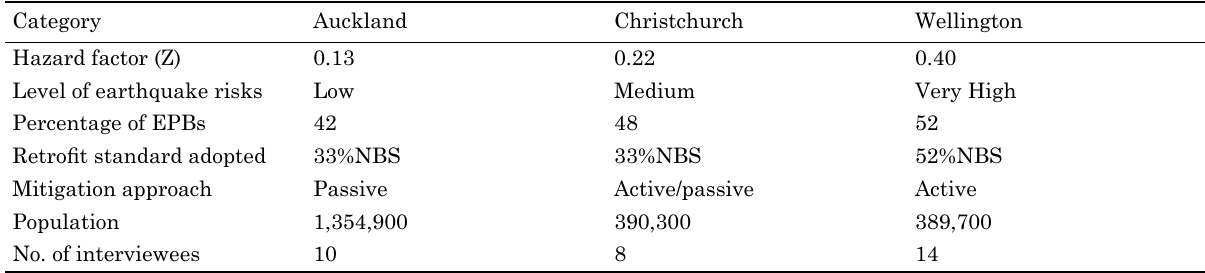
Table 1. summary of participated cities’